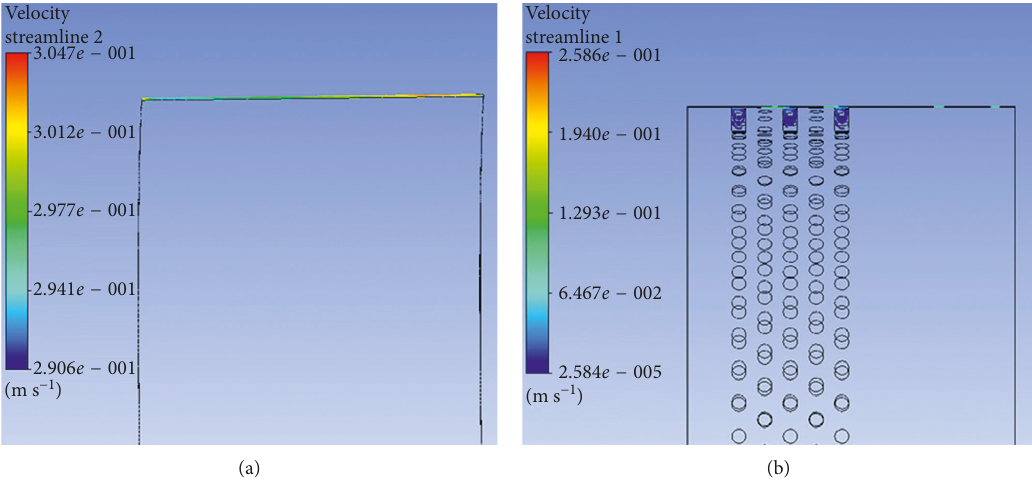
Figure 11: Piston cross section streamline: (a) L-Standard piston and (b) dimpled